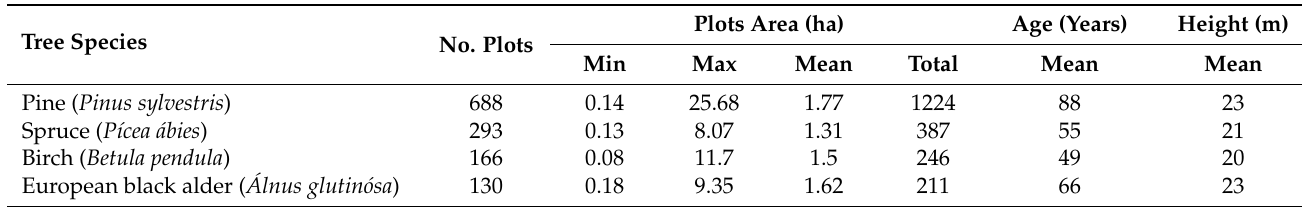
Table 2. Summary statistics of selected FI study plots, used in the given research and separated into four main dominant tree species.